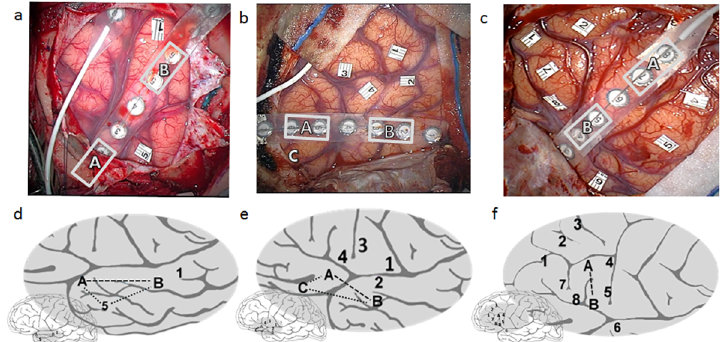
Fig 1. Examples of single and multi-site effects. One case exampleof a multi-site temporal effect (a,d— patient 10), one case exampleof a cross-lobalmulti-site effect (fronto-temporal; b,e—patient8) and one case exampleof a multi-site frontal effect (c,f—patient 6). (a-c) intra-operative photography, (d-f) stimulation locationon scheme (effects were alignedusing both angio and navigation system photographs). (a) Patient 10: singlesite DCS found a single word deafnesseffect (1). A cortical strip was placed on the superior temporalgyrus, and a two-site stimulationretrieval disturbance effect was found (A-B). An Ojemann stimulator was simultaneously appliedon location5, causing a three site semantic paraphasia effect. (b) Patient 8: single site DCS found a speech arrest effect (4), a word deafnesseffect (2) and two motor effects (1,3). A cortical strip was placed crossing the sylvian fissure, and a two-site stimulationsyntax disturbance effect was found using a frontal site and a temporalsite.). An Ojemann stimulator was simultaneously applied on locationC, causinga three site verb-generation effect. (c) Patient 6: singlesite DCS found a speech arrest effect (5), five semanticeffects (1,2,3,7,8) and a word deafnesseffect (6). A cortical strip was placedupon the inferior and middlefrontal gyri and a two-site stimulationphonological effect was found. Dashedlines represent2-site and 3-site MSS affects.